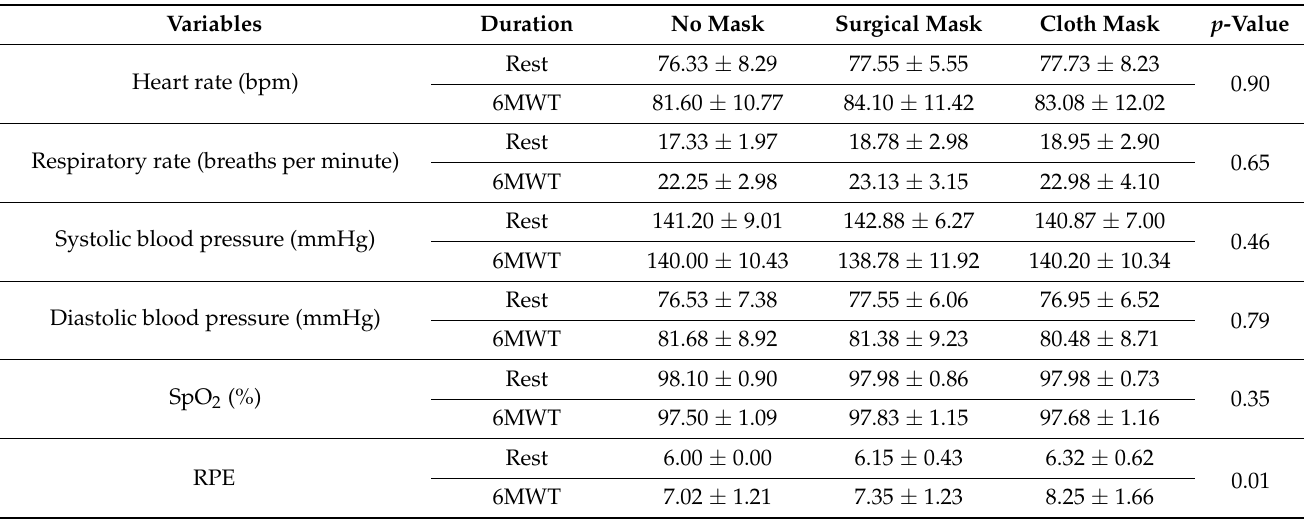
Table 4. Effects of face masks on cardiorespiratory parameters at rest and